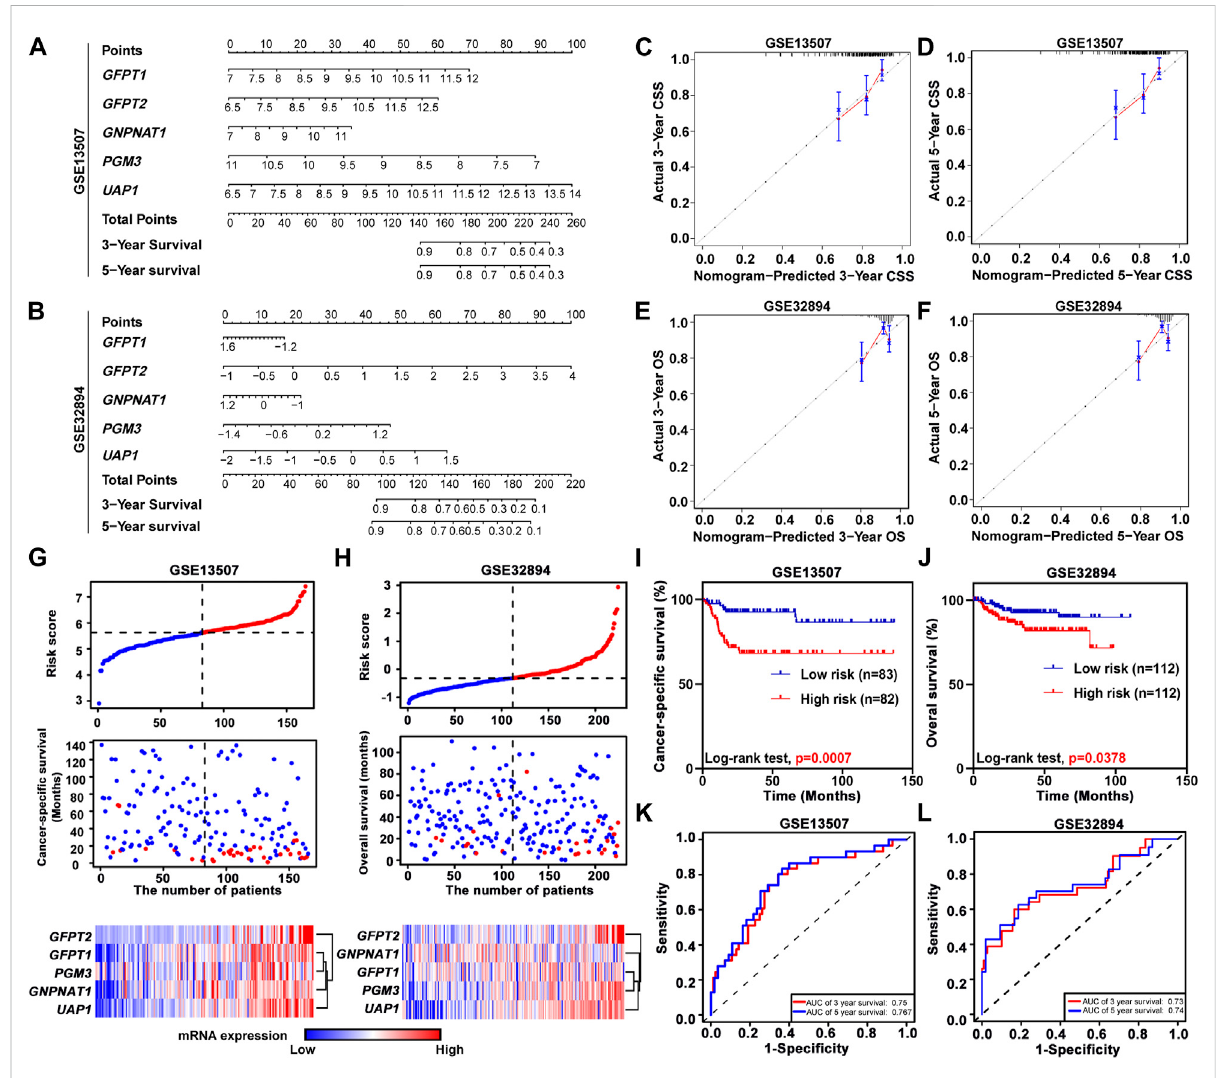
FIGURE 3 The relationship between prognostic value and the risk score of HBP in GSE13507 and GSE32894 datasets. (A,B) The nomogram was used to predict 3-, and 5-years cancer-speci fi c survival CSS; (A) and overall survival OS; (B) . (C – F) The calibration curves of 3-, and 5-years CSS or OS of GSE13507 (C,D) and GSE32894 (E,F) datasets. The gray dots and gray lines represented the ideal prediction model, and the blue dots and red lines represented the observed models. (G,H) The distribution of risk scores, CSS-status and OS-status, and signature gene expression pro fi les in GSE13507 (G) and GSE32894 (H) datasets, respectively. (I,J) Kaplan-Meier plots of CSS of UBC patients in GSE13507 (I) and OS of UBC patients in GES32894 (J) datasets,strati fi edbythelevelofriskscore,respectively. p values < 0.05werelabelledinred. (K and L) Time-dependentROCcurvesfor 3- (red lines) and 5-years (blue lines) survivals in GSE13507 (K) and GSE32894 (L)